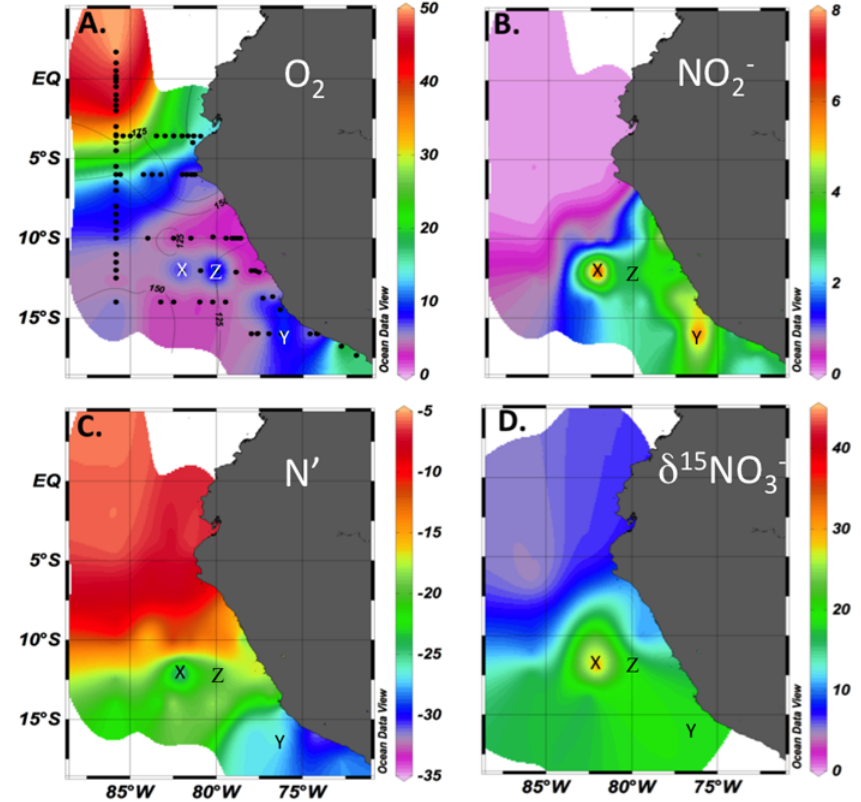
Fig. 1. Biogeochemical maps of the Peru OMZ from a series of stations constituting 6 transects normal and 1 transect parallel to the coast occupied during cruises M77/3 and M77/4 of the German research vessel R/V Meteor in January and February of 2009. Properties are shown along a constant density surface ( σ θ = 26.3kgm − 3 ) within the upper portion of the OMZ corresponding to a depth range of 100 to 170m. (A) O 2 concentration (µmolkg − 1 ), station locations, and depth of the σ θ = 26 . 3kgm − 3 surface. (B) NO − concentration (µmolkg − 1 ). (C) 2 Nitrogen anomaly (N 0 , µmolkg − 1 ) calculated as [NO − ] + [NO − ] − 16 × [PO − 3 ]. (D) The δ 15 N of NO − . When southward intensification 3 2 4 3 of suboxic conditions reaches [O 2 ] < 5µmolkg − 1 , the onset of N-loss processes is evident. Location of Station 7, a hotspot for N-loss, is marked by an “X”. Data smoothing to produce this visualization diminishes somewhat the extrema found at Station 7 (see Fig. 2). A second hotspot (Station 29) was also detected (marked by a “Y”), but is not discussed in the text due to a less comprehensive data set for this site. The position of a more normal comparison station (see Fig. 2) is marked by a “Z”.